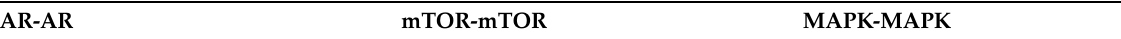
Table 1: Common intra-pathway connections between STRING and GeneMANIA for all three pathways.